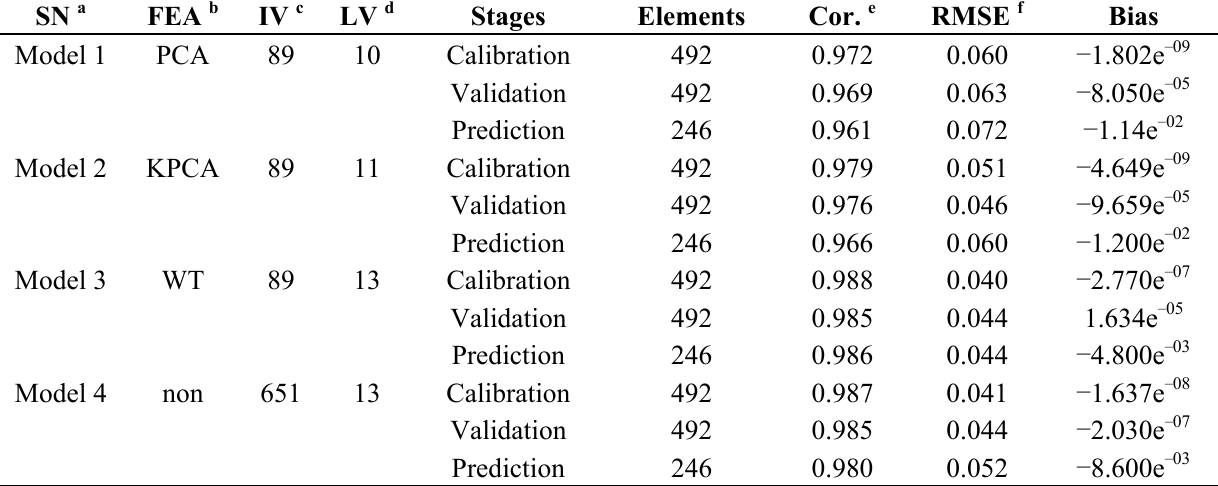
Table 6. Results of four PLS models corresponding to PCA, KPCA, WT and original spectral